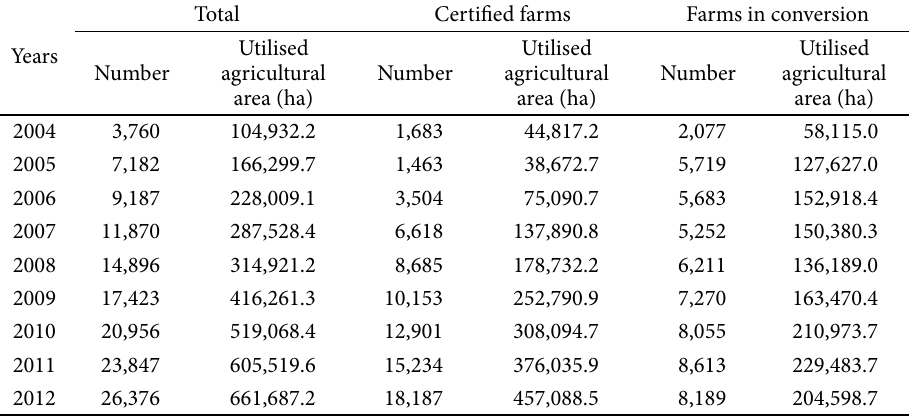
Table 1. Number of organic farms in Poland in years